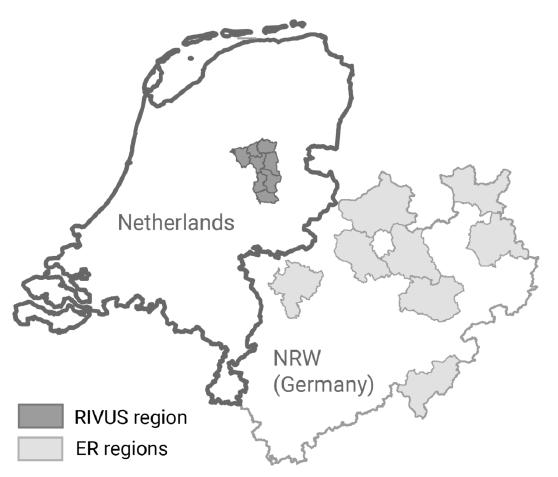
Figure 1. Location of the case